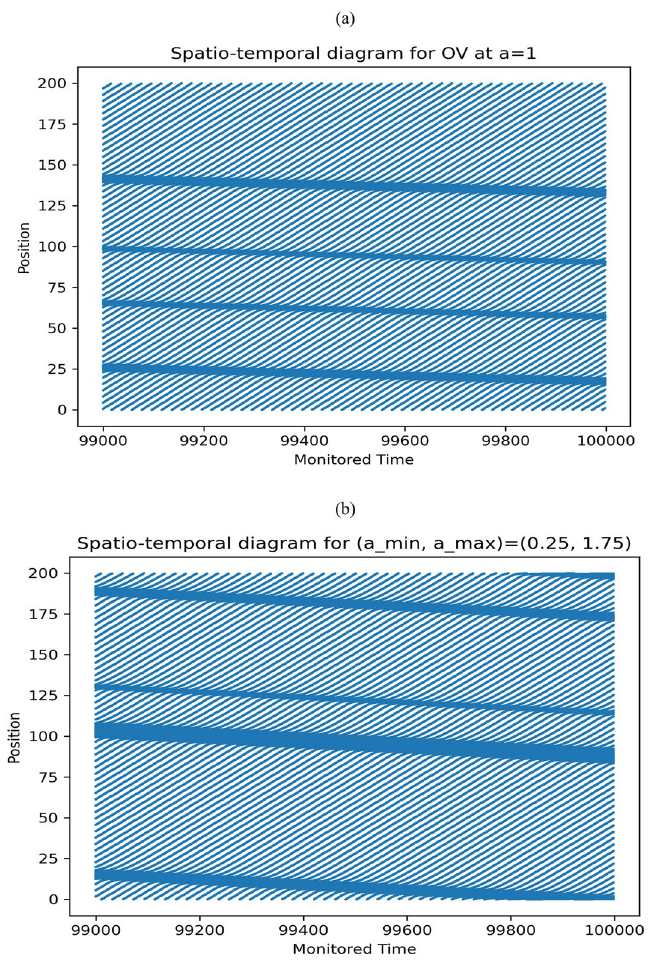
Figure 7. A comparison analysis for the spatiotemporal diagrams of the conventional OV model and proposed HDDS